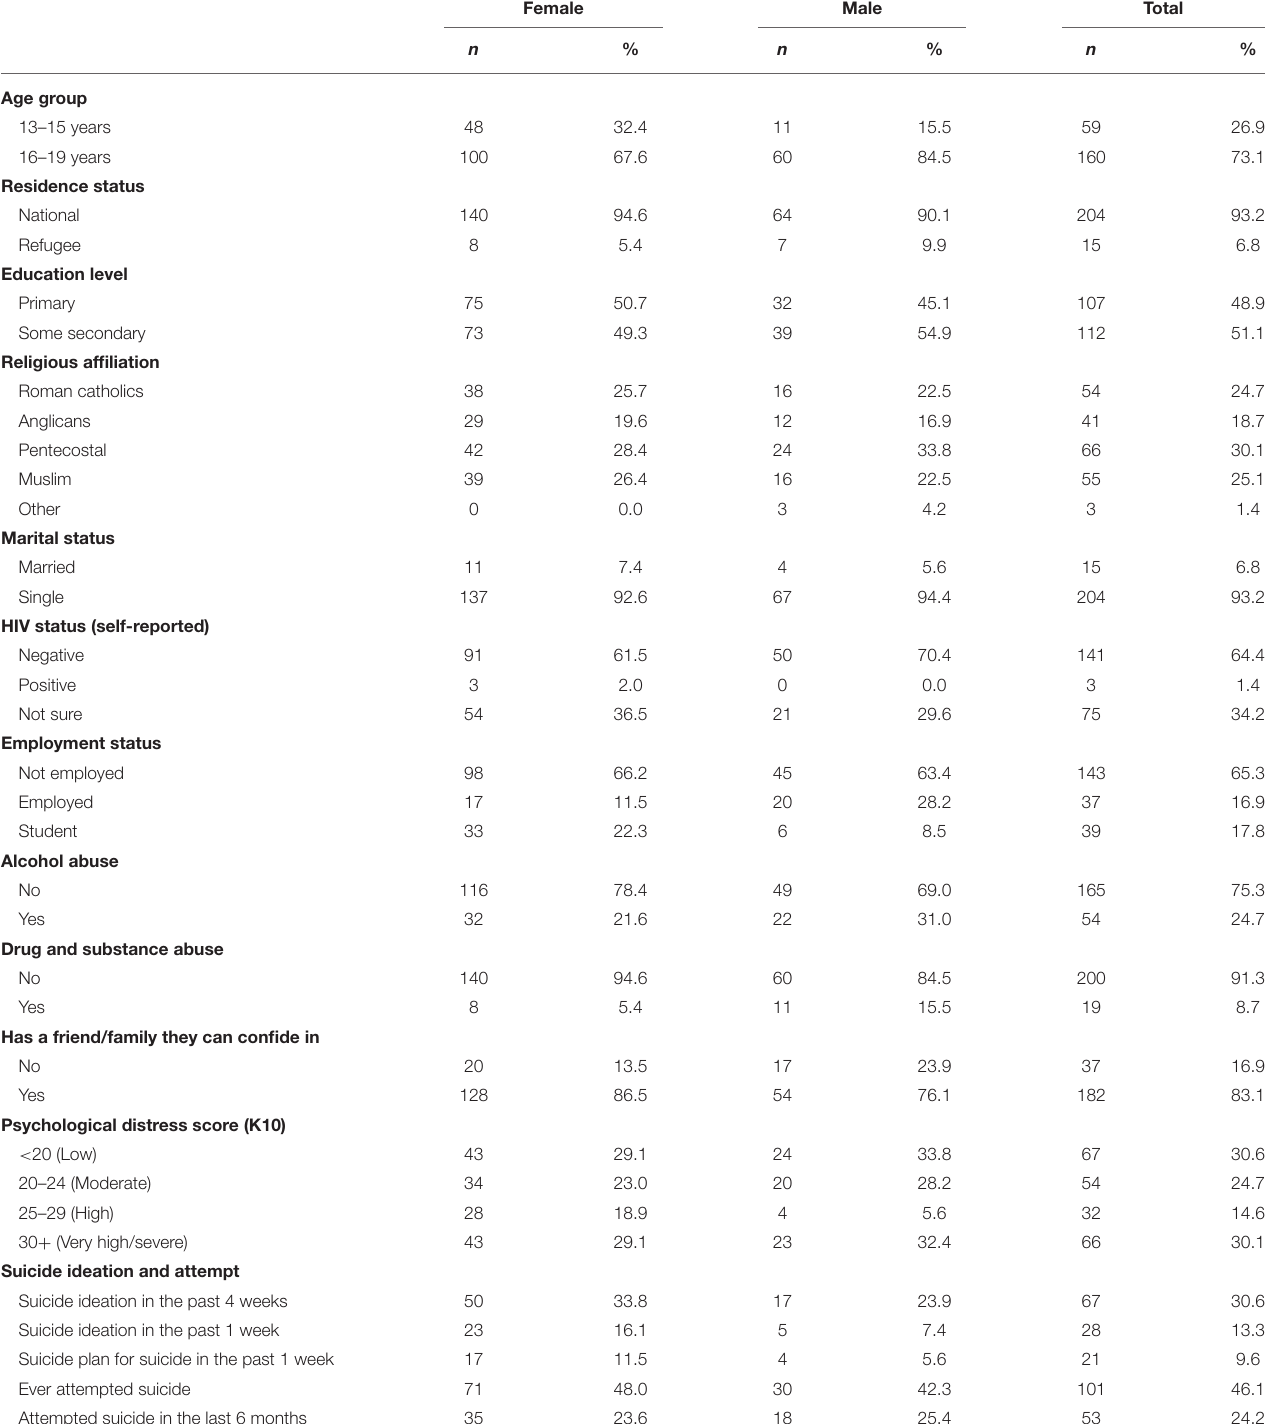
TABLE 1 | Sample demographics and behavioral